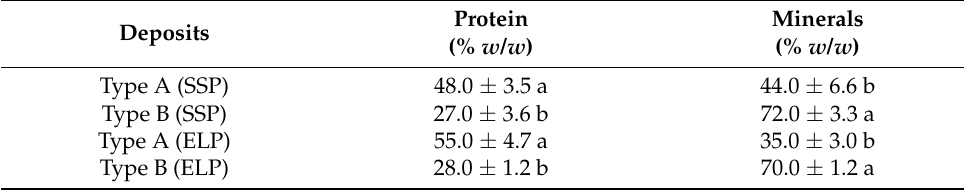
Table 2. Composition of Type A and B deposits on stainless steel plates surface finish 2B (SSP), and electropolished (ELP). Deposits